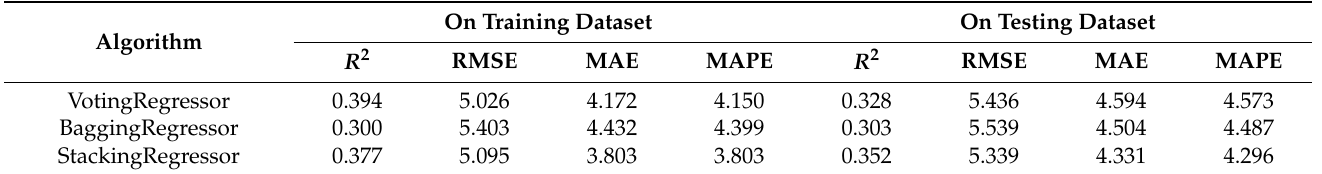
Table 2. Comparison of the ensemble model performances in terms of R 2 , RMSE, MAE, and MAPE.